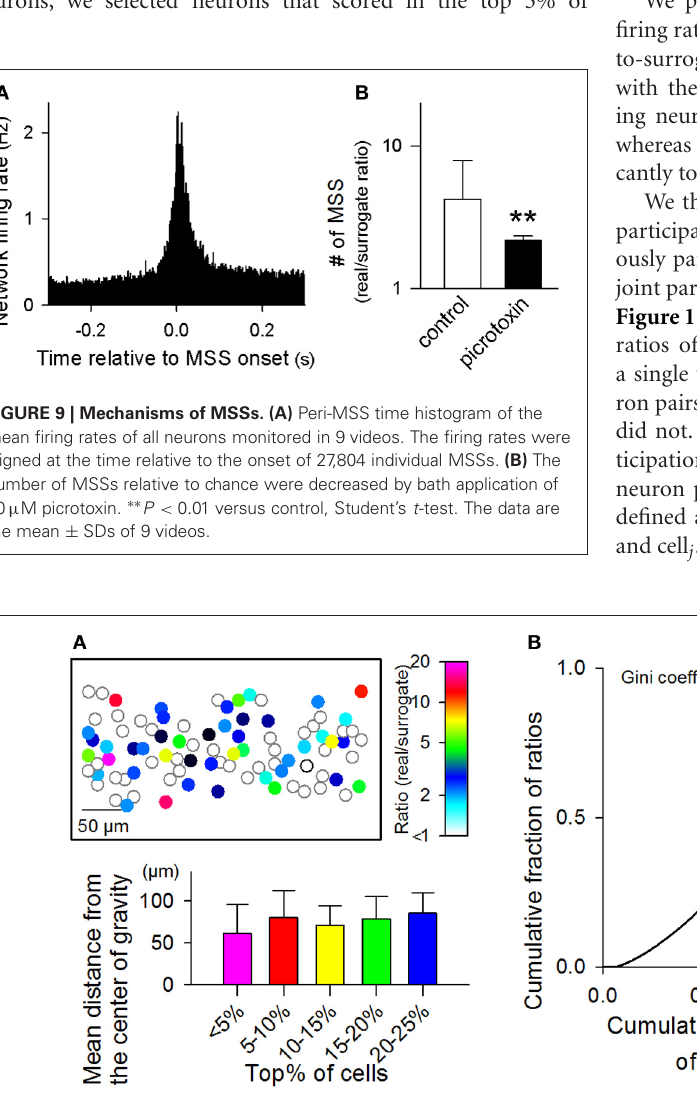
by the proportion of cells with the lowest ratios. A Lorenz curve is used to show the degree of “inequality” of a distribution defined by two variables (herein, the real-to-surrogate ratio of individual cells versus the number of cells with a given real-to-surrogate ratio). The inequality can be represented by a Gini coefficient, a number between 0 and 1, where perfect equality has a Gini coefficient of zero, and absolute inequality yields a Gini coefficient of 1. In this case, the Gini coefficient was 0.44. (C) The ratios of the numbers of MSS participations of individual cells in real datasets to the mean values in 20 randomized surrogates are plotted against their mean firing rates. Color-edged circles are 5% significant data points between real datasets and surrogates (paired- t test). The data are the mean ± SDs of 9